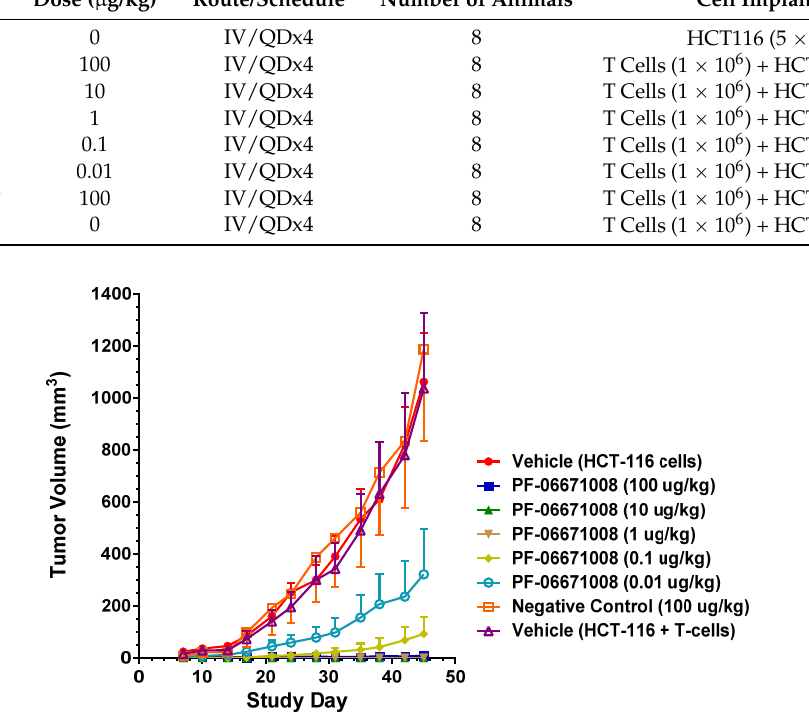
Table 7. Study Design for HCT116 Tumor Model.